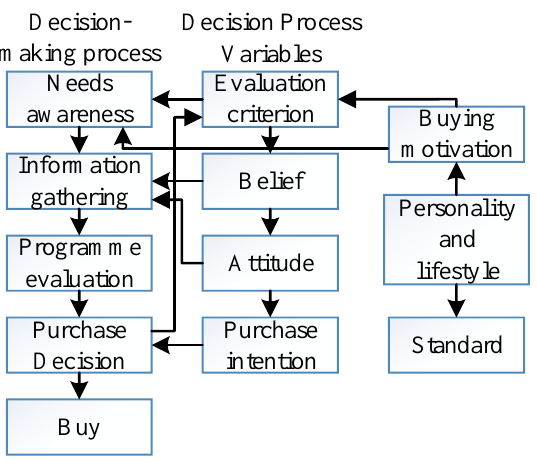
Figure 5. Decision model of consumer purchase behavior.